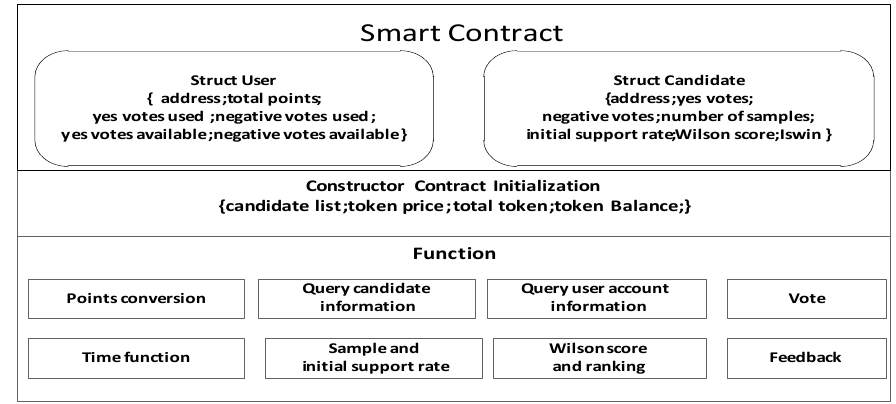
Figure 3. Smart contract structure diagram.